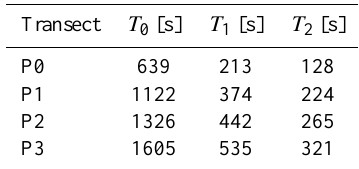
Table 6. The first three oscillation periods for each